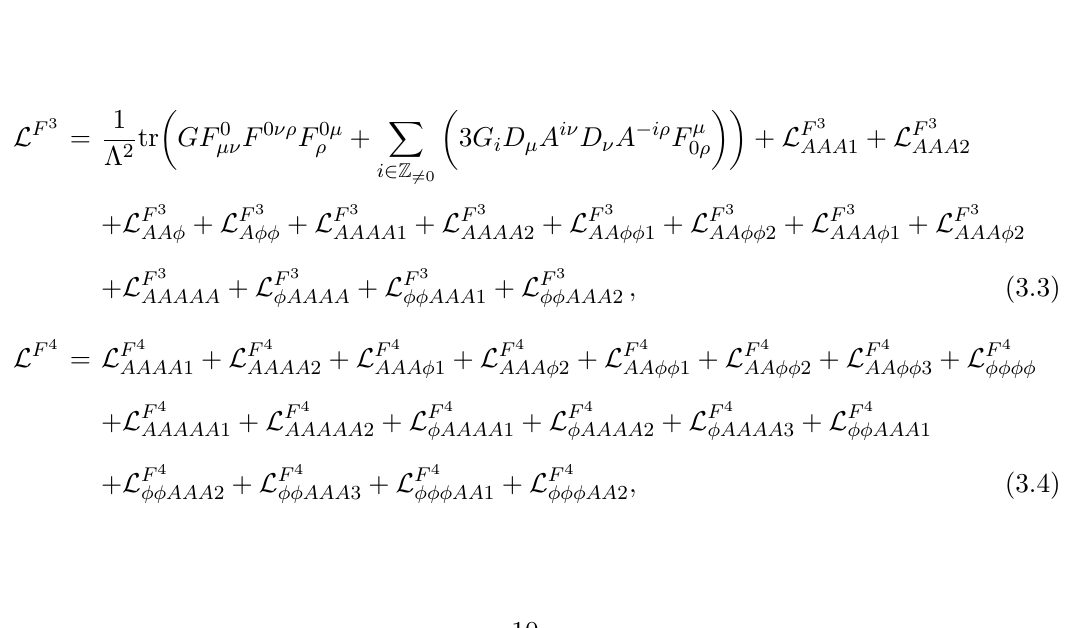
Table 1 . Coefficients of the